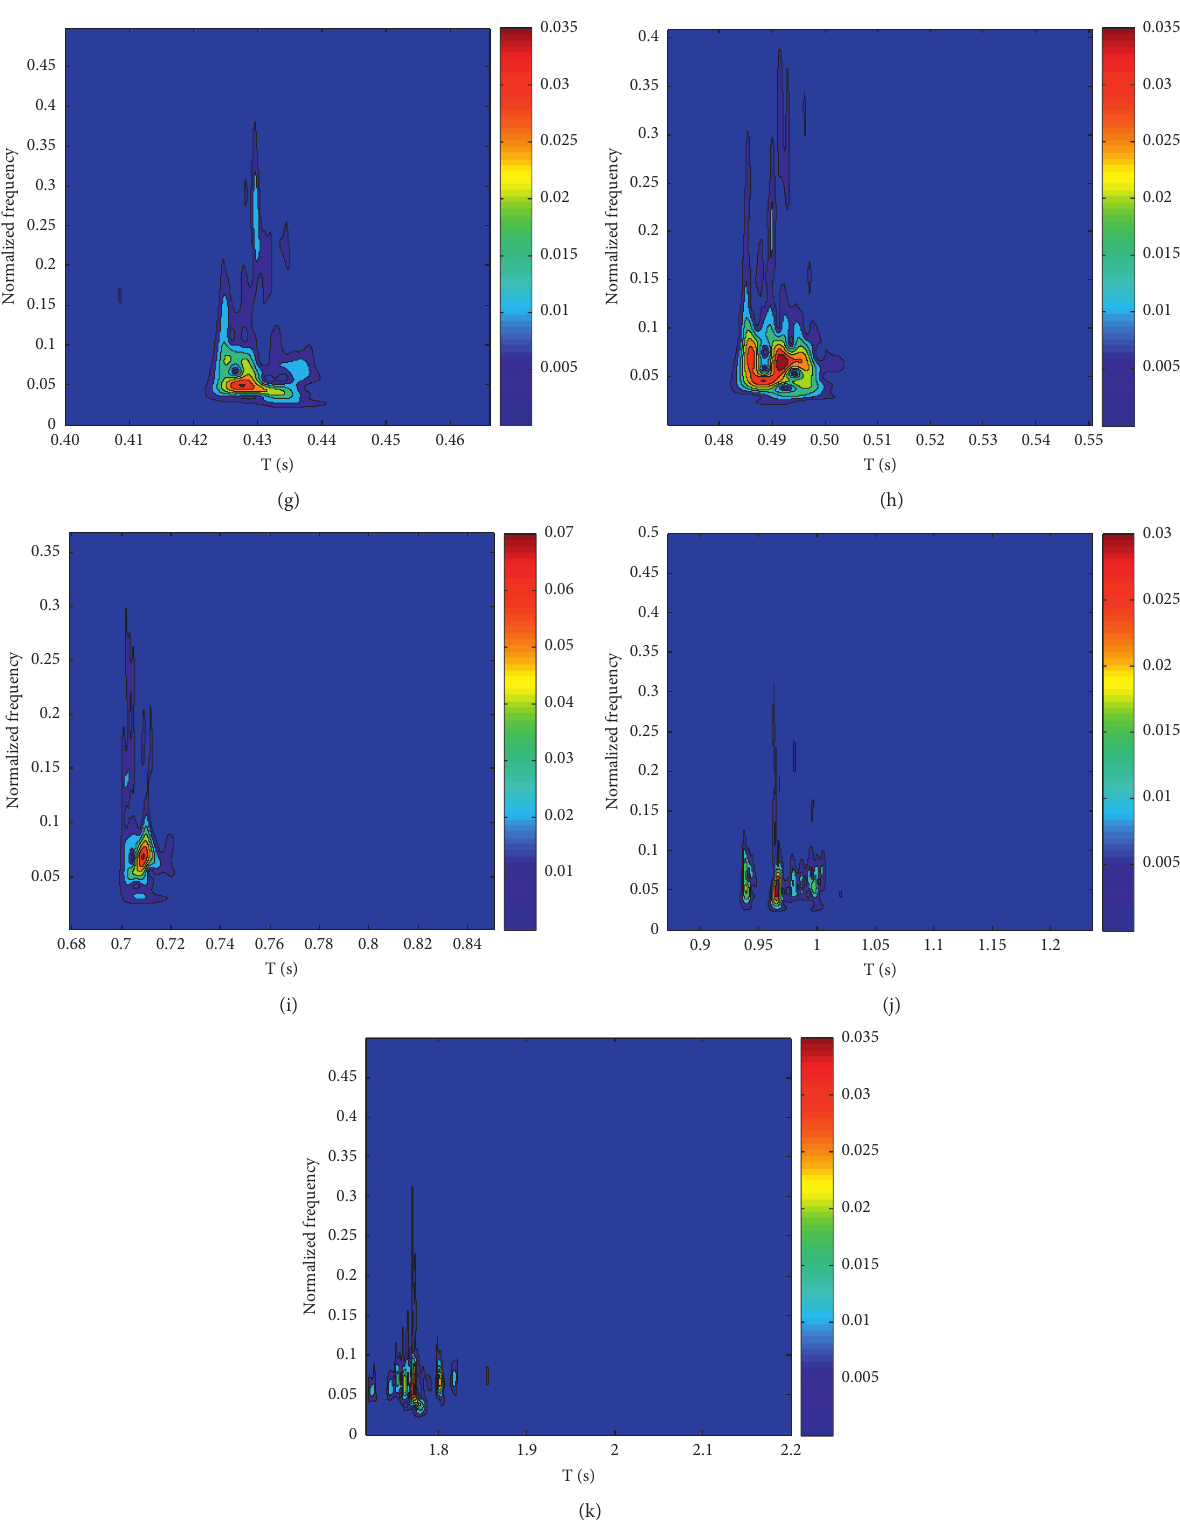
Figure 5: Energy distribution of each detonator using S transform: (a) energy distribution of MS1 signal; (b) energy distribution of MS3 signal; (c) energy distribution of MS5 signal; (d) energy distribution of MS7 signal; (e) energy distribution of MS8 signal; (f) energy distribution of MS9 signal; (g) energy distribution of MS10 signal; (h) energy distribution of MS11 signal; (i) energy distribution of MS13 signal; (j) energy distribution of MS15 signal; (k) energy distribution of MS19